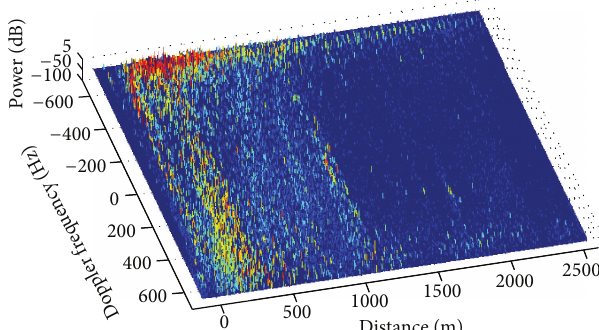
Figure 7: Doppler spectrums at different positions.